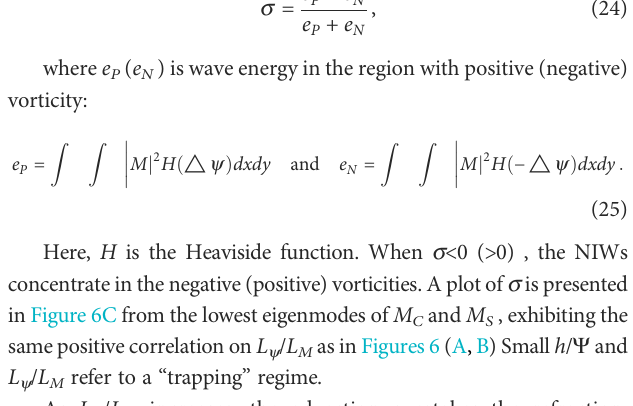
ffiffiffi p hk 2 = z : 2,1,5, respectively. Shaded areas indicate 2 0 = 0 0